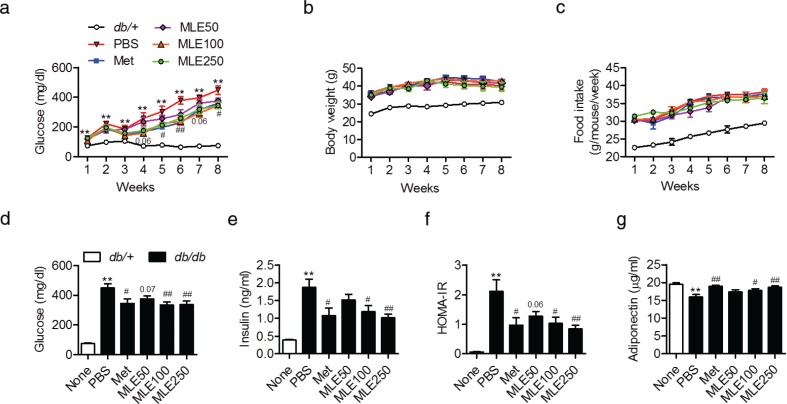
Effects of MLE supplementation on glycemic control in db/db mice. Male db/db mice received PBS, metformin (100 mg/kg), or MLE (50, 100, and 250 mg/kg) once daily for 8 weeks by oral gavage. (a) Fasting blood glucose, (b) body weight, and (c) food intake changes were recorded at the indicated times. (d–g) At the end of the study, glucose, insulin, and adiponectin concentrations were analyzed and the HOMA-IR scores were calculated. Values are expressed as mean±SEM (n = 7/each group). **p < 0.01 versus db/+, #p < 0.05 and ##p < 0.01 versus db/db+PBS. Met, metformin; MLE50, MLE 50 mg/kg; MLE100, MLE 100 mg/kg; MLE250, MLE 250 mg/kg.